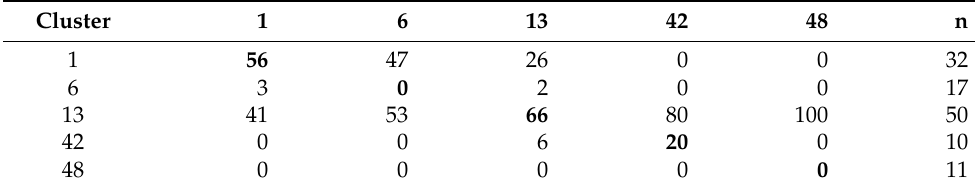
Table 2. Percentage correct classification for multinomial logistic regression of cluster membership us- ing environmental variables (wind speed, solar irradiance, and lake). Percentage correct classification in bold on diagonal. n = number of days in each